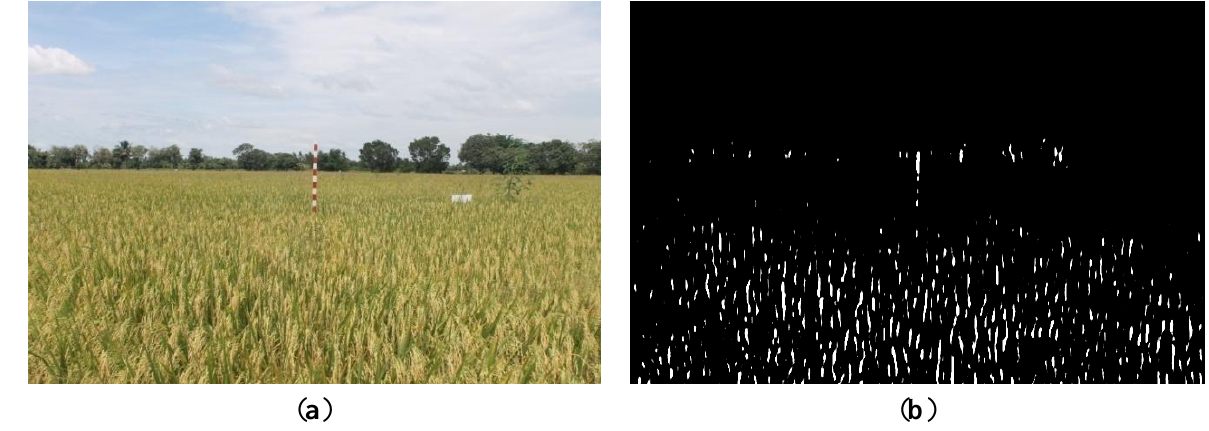
Figure 18. Comparison between ( a ) RGB and ( b ) resultant binary images using proposed method with red band feature on 12 August 2012.